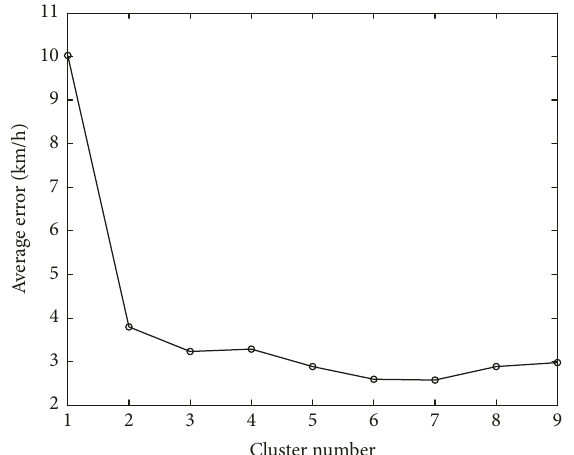
Figure 6: Relationship between the number of clusters and the test errors.